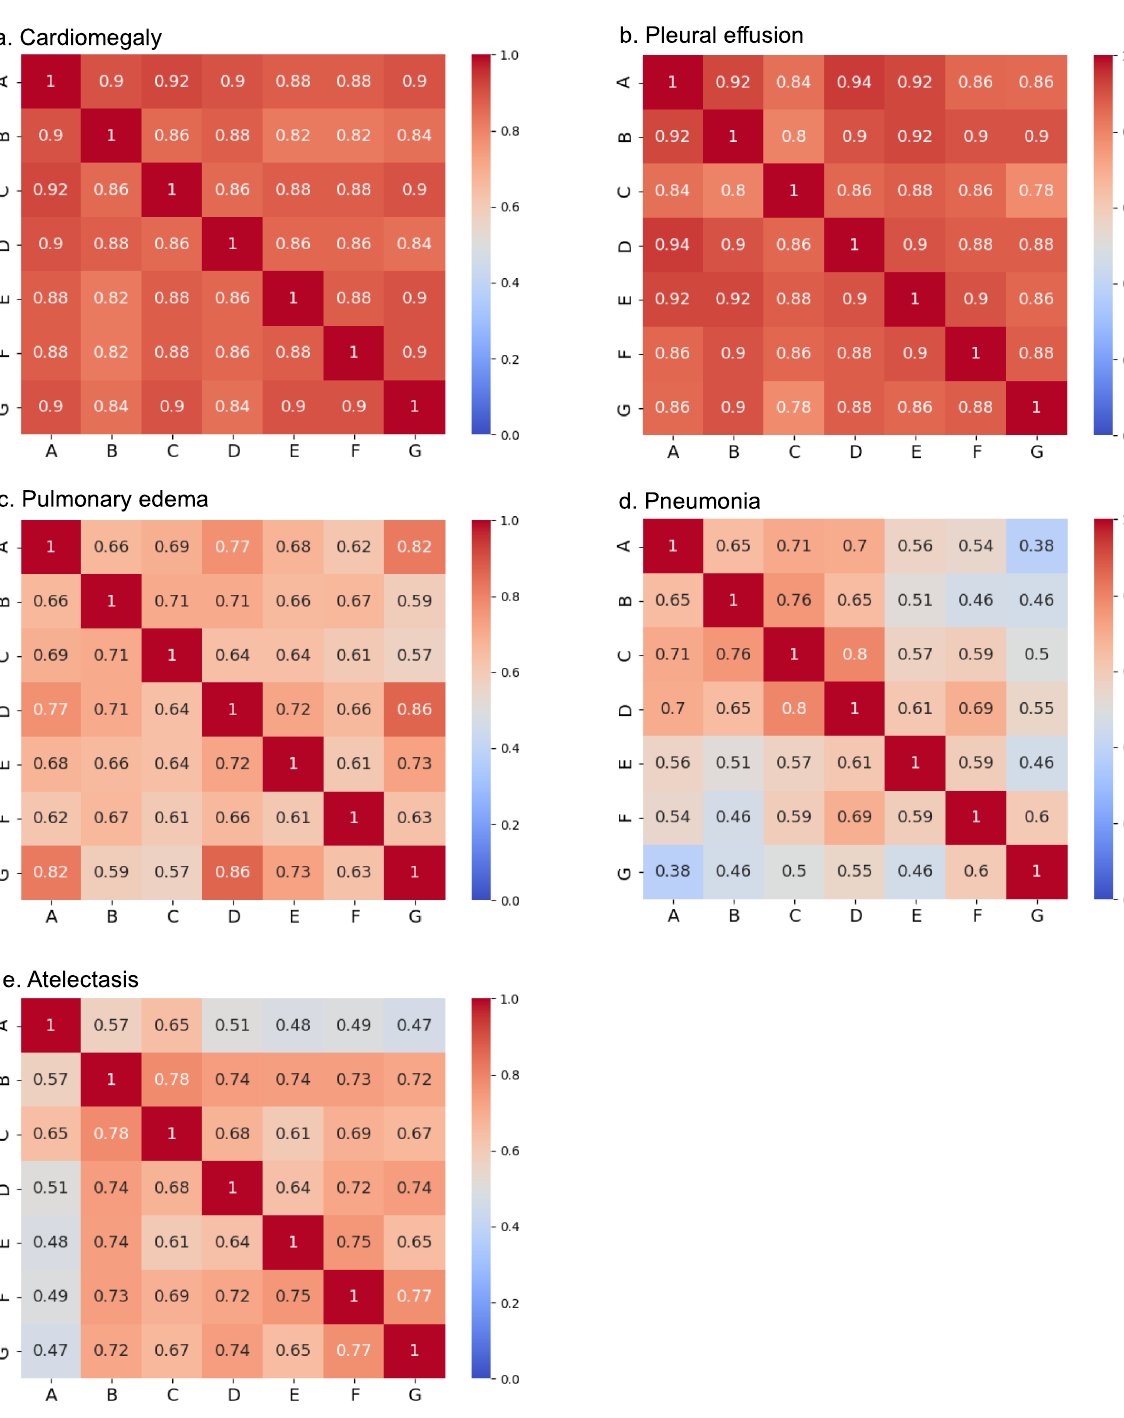
Fig. 7 Pairwise kappa statistics between the seven expert radiologists, for each of the fi ve clinical output labels. For each of the fi ve auto-labeled clinical output labels — a cardiomegaly, b pleural effusion, c pulmonary edema, d pneumonia, and e atelectasis — the pairwise kappa statistics estimating inter- observer variability are shown in the respective color-coded matrices 43